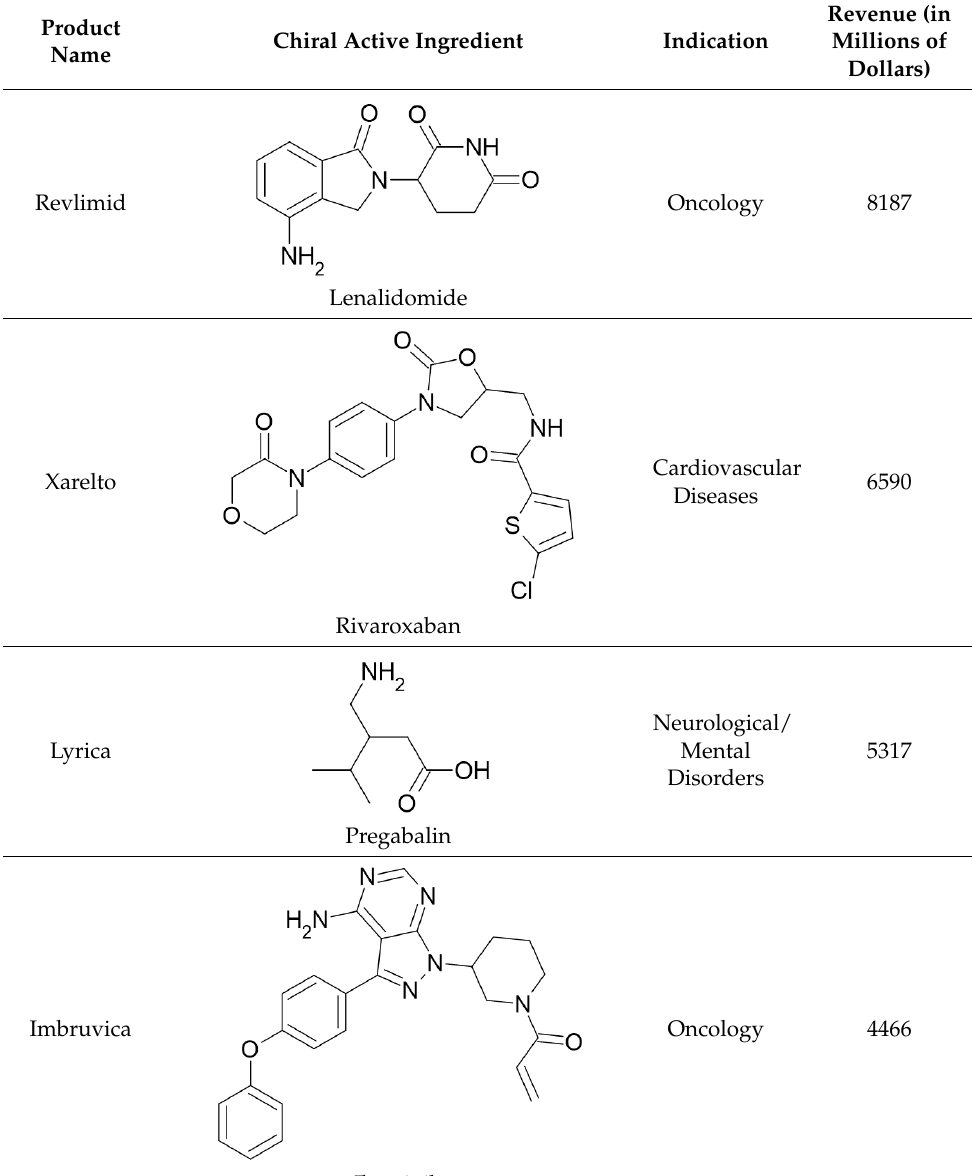
Table 4. Top seller drugs worldwide in 2017 with chiral active ingredients (PHARMACOMPASS, 2019).